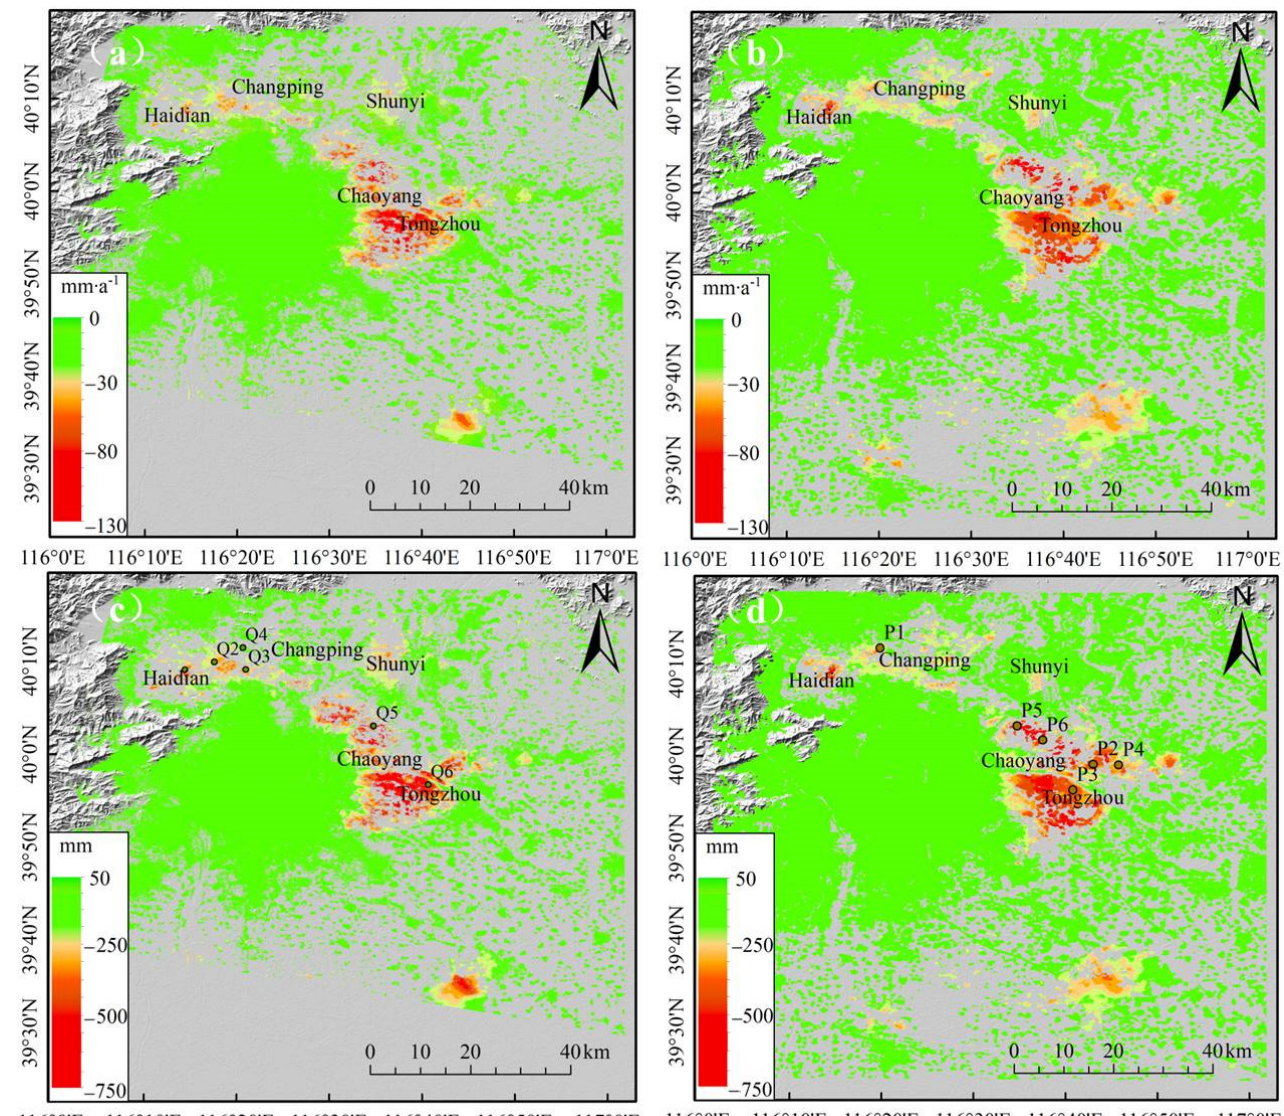
Figure 4. Deformation results of land subsidence along the LOS in Beijing during 2003–2010 and 2015–2020. Mean deformation velocity during 2003–2010 ( a ) and 2015–2020 ( b ). Cumulative deformation during 2003–2010 ( c ) and 2015–2020 ( d ). Note: Q1–Q6 ( c ) and P1–P6 ( d ) represent the extracted deformation feature points in typical subsidence area. The black marks in the figure are mainly deformation zones. The colored dots from green to red represent InSAR values.